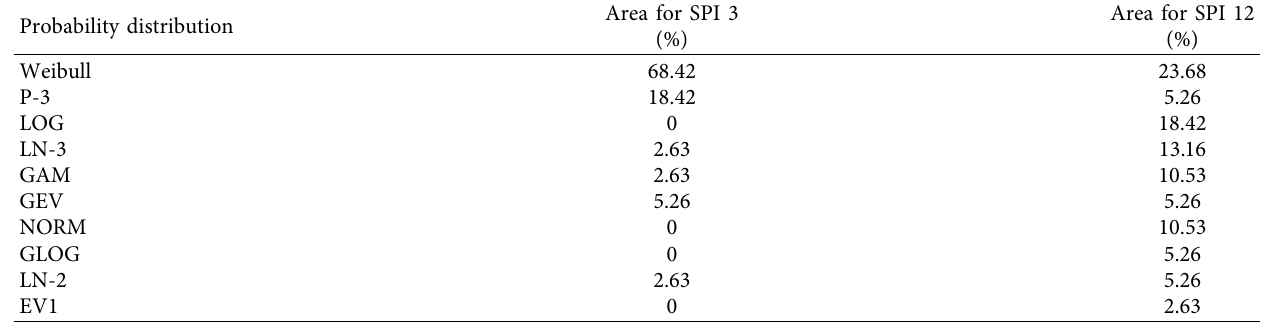
Table 5: Areal percentage of the best ft distributions given in Figure 3.